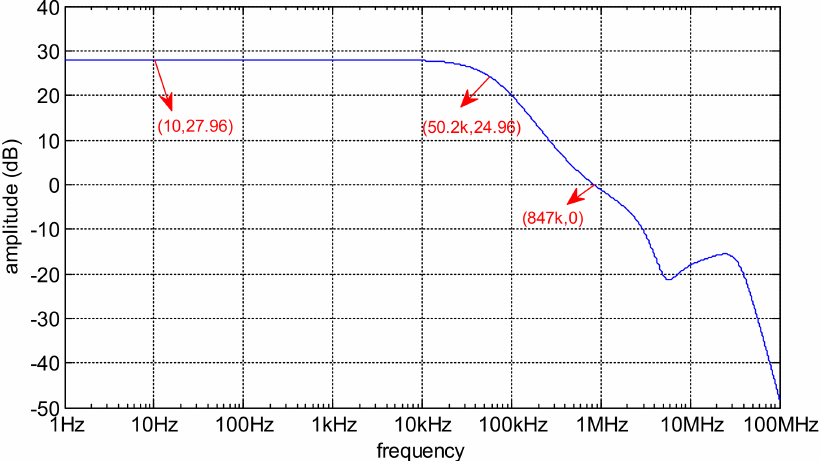
Figure 23. Simulated frequency–amplitude characteristic for the power amplifier using general operational